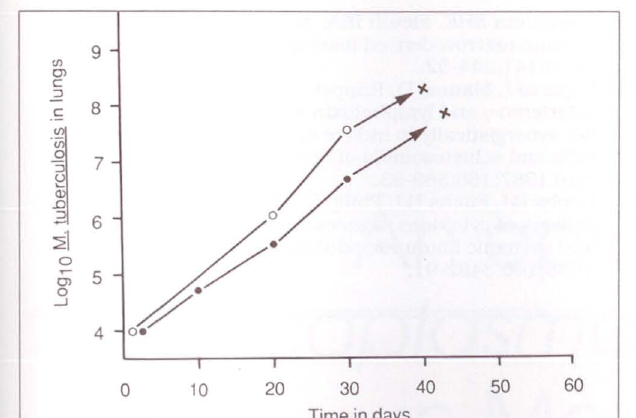
Figure 4) Growth ojM tuberculosis in the lungs of mice injected by the aerogenic route treated with cytokines by the intra peritoneal route. Mice were infused with 5 etg of interferon gamma (IFN-y) and 5 etg of tumour necrosis factor (TNFa) daily {•) by the intraperitoneal route. or heat-inactivated cytokines (o). Differences in colony forming unit (cju) counts between groups is significant at days 20 and 30 (P<0.05). Data expressed as in Figure 1. At day 30 there is a significant difference in log cju (P<0.05. student's t